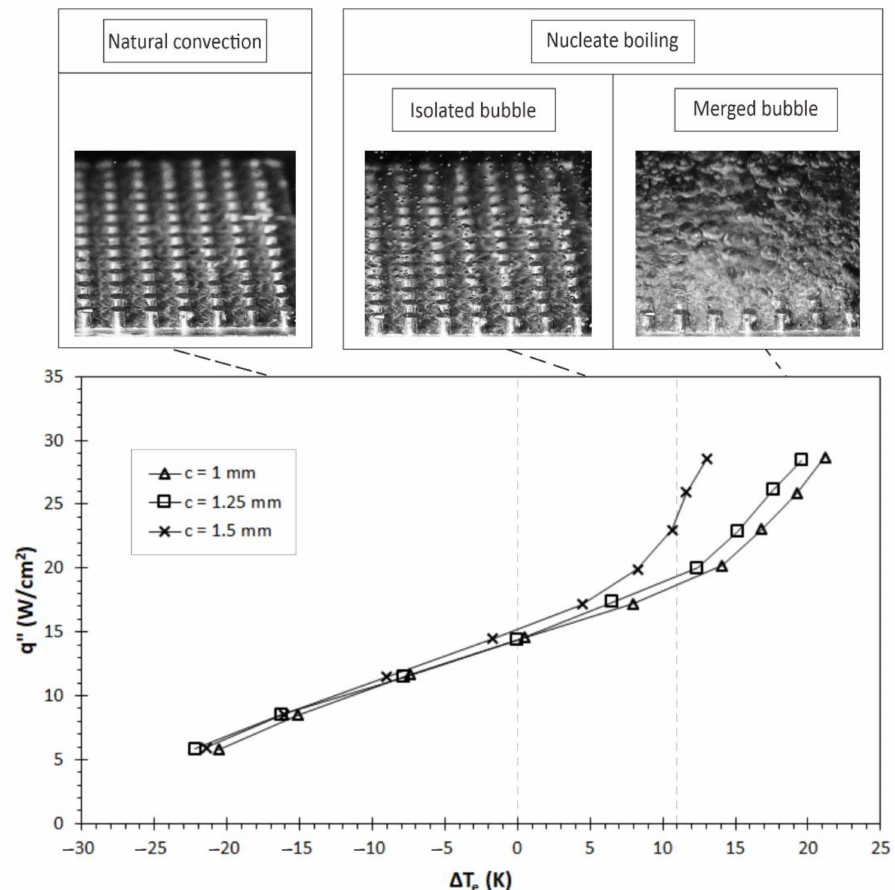
Figure 3. Boiling curve and regime from circular pin fin